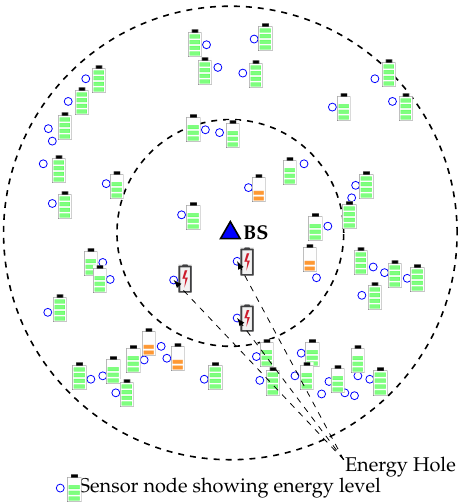
Figure 1. Energy hole problem in WSNs.